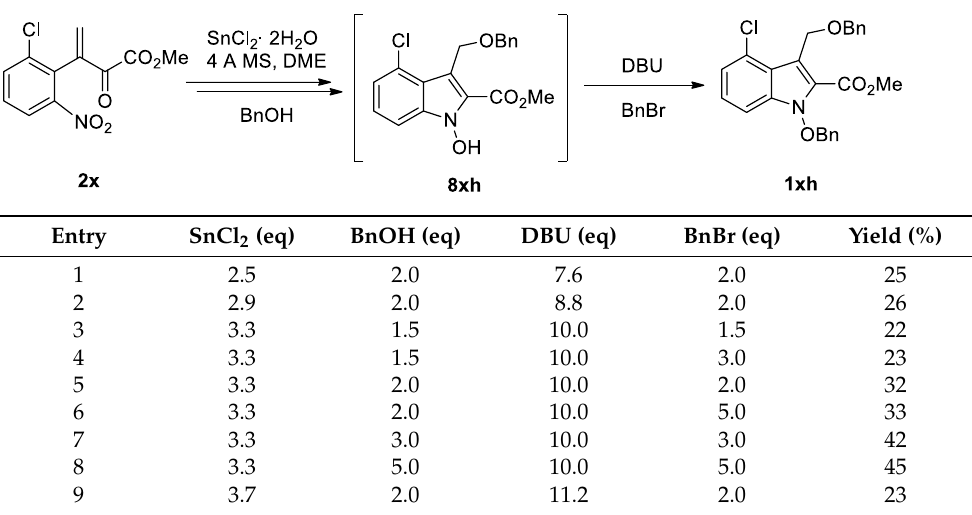
Table 2. Optimization of the reaction conditions for 1xh a .